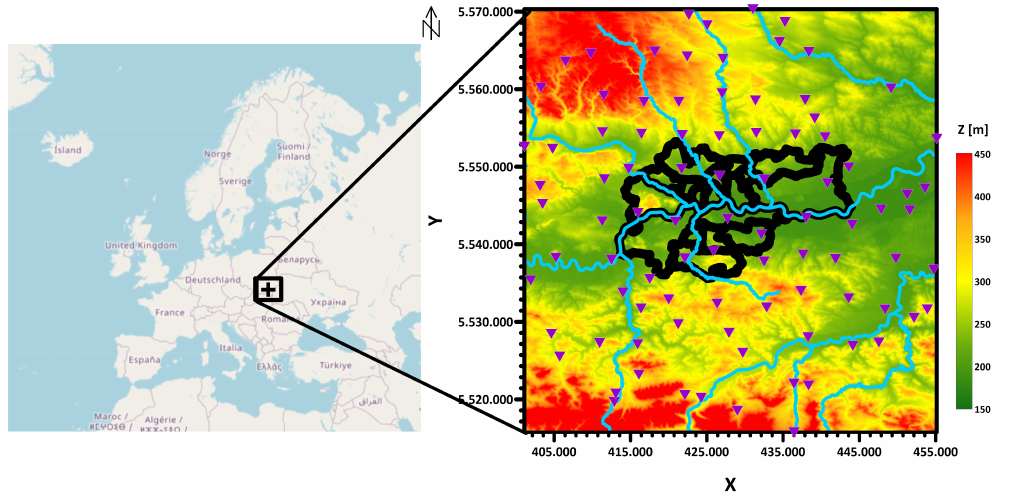
Figure 1. Krakow’s digital terrain model (back lines—city districts), sensor’s locations (purple triangles), main rivers (blue lines). Data sources: Digital terrain—European Union, Copernicus Land Monitoring Service 2022, European Environment Agency (EEA); European Union Map by ©OpenStreetMap —(https://www.openstreetmap.org/ accessed on 2 March